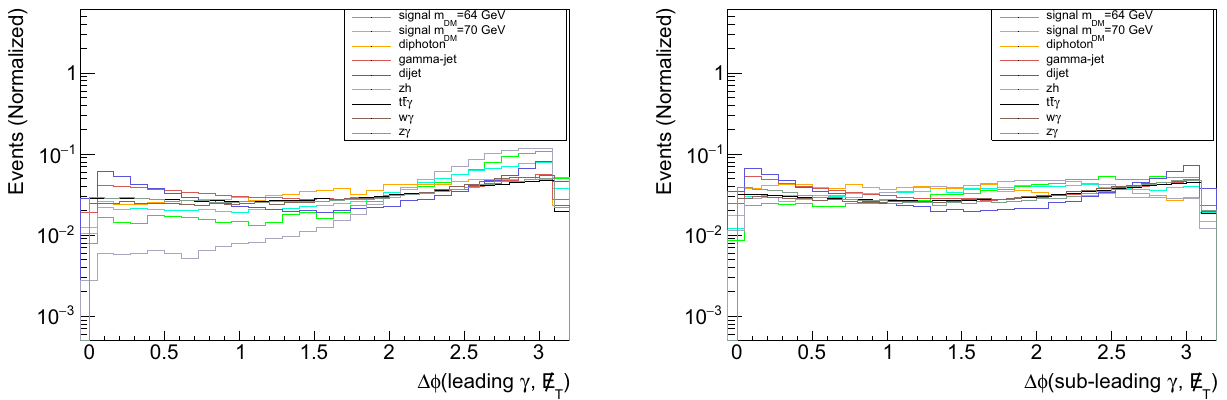
Fig. 10 Normalized distributions of (cid:15) R between the leading and sub-leading photons (left) and number of jets (right)